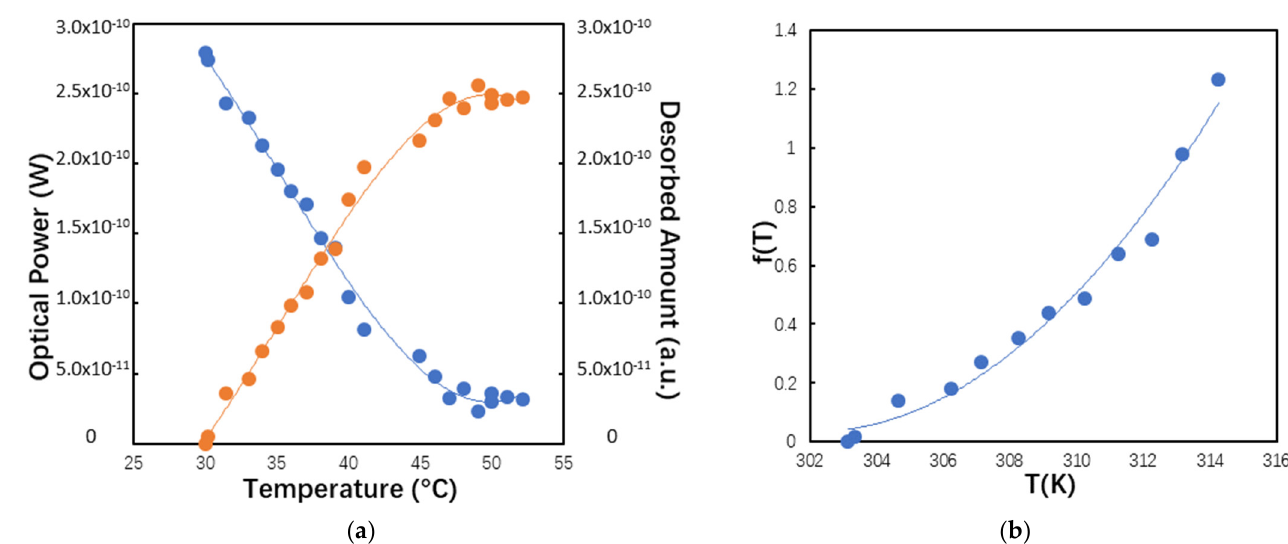
Figure 5. ( a ) Thermally stimulated desorption of GO in SMF fibers: shown in blue is the variation of reflected optical power as a function of temperature, and shown in orange is the quantity of desorbed GO. ( b ) Graph of f ( T ) = ln as a function of absolute temperature. The blue line corresponds to the fitting of the f ( T ) points with the second term of Equation (3).